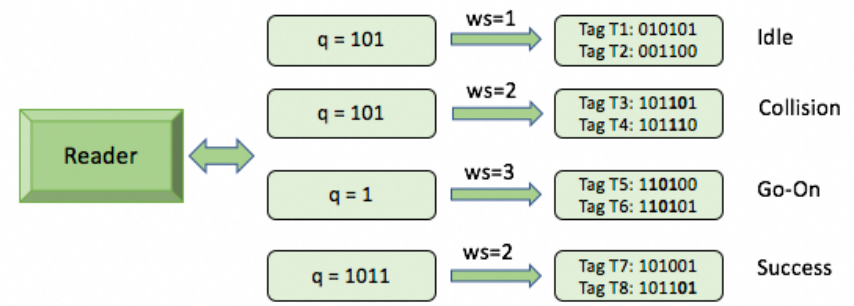
Figure 3. Window synchronized